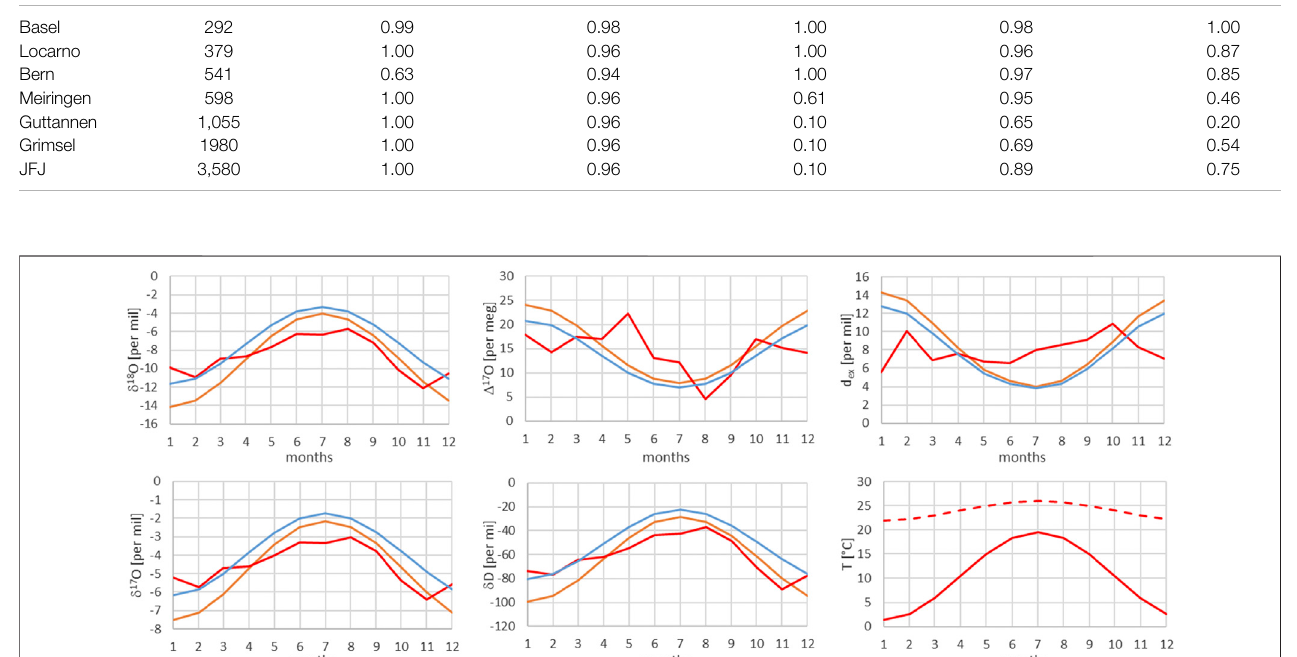
FIGURE7| Comparisonofmonthlymeanmeasured (red)andmodeled(fortheisobariccase(orange)andforthedryadiabaticcase(blue))isotoperatios forBasel. The dashed red line corresponds to the assumed source temperature.